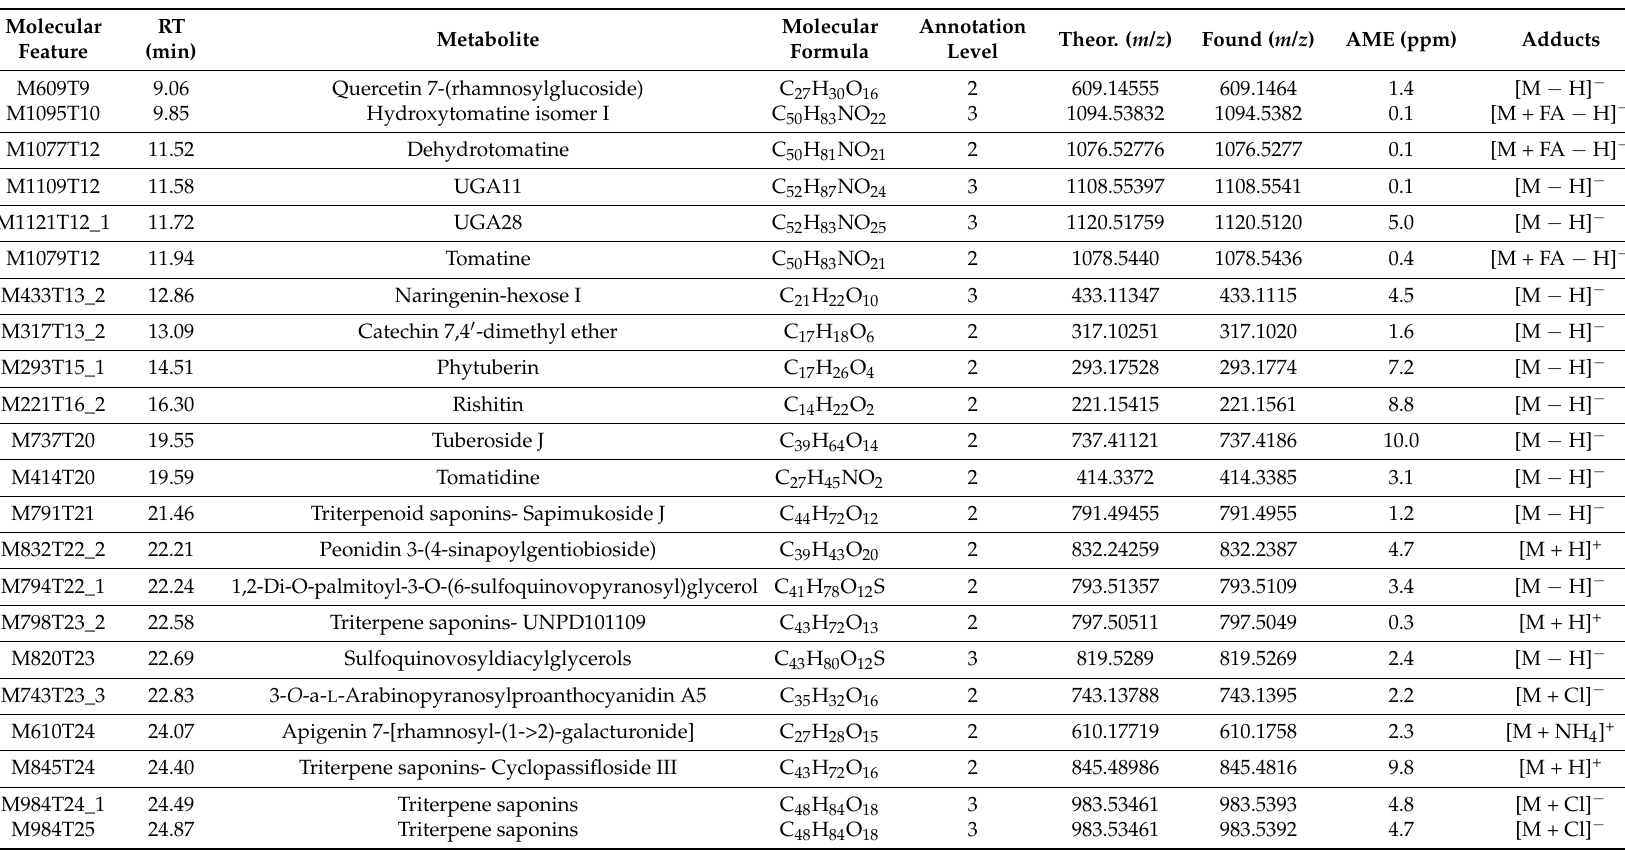
Table 1. Principal metabolites associated with tomato late blight annotated with LC-MS/MS data. Annotation level: identified metabolites (level 1),